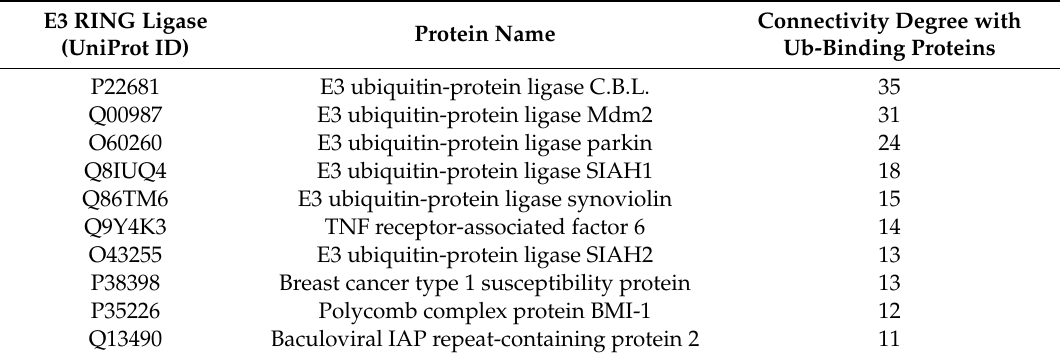
Table 1. Top Ub-binding E3 RING ligase candidates based on network analysis involving their shared interactors with known Ub-binding proteins. The connectivity degree reflects the number of common interactors among Ub-binding proteins and E3 RING ligases and is indicative of the potential structural similarity of the E3 ligase to Ub-binding protein.